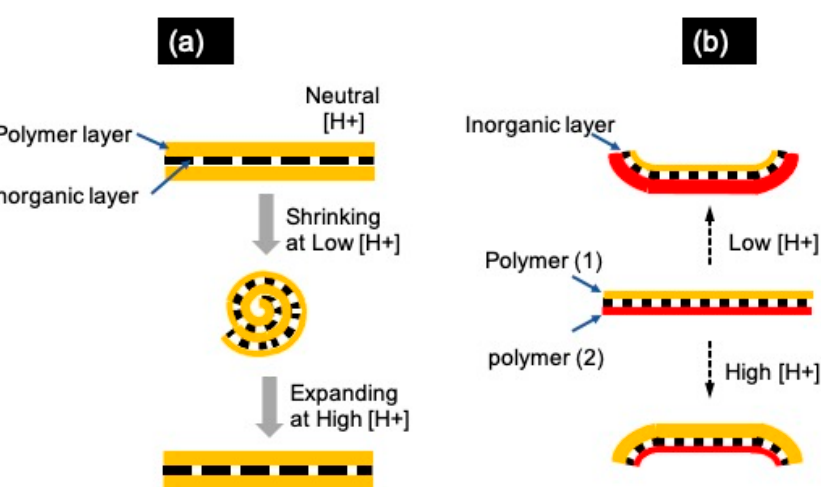
Figure 10. ( a ) Schematic scrolling/unscrolling mechanism of a hybrid NSHs, showing the reversible effects under various pH conditions. ( b ) A controlled scrolling/unscrolling mechanism of the Janus NSHs, comprising inorganic layers adsorbed onto two oppositely charged pH-sensitive polymer layers, presenting side-directed rolling in response to pH.